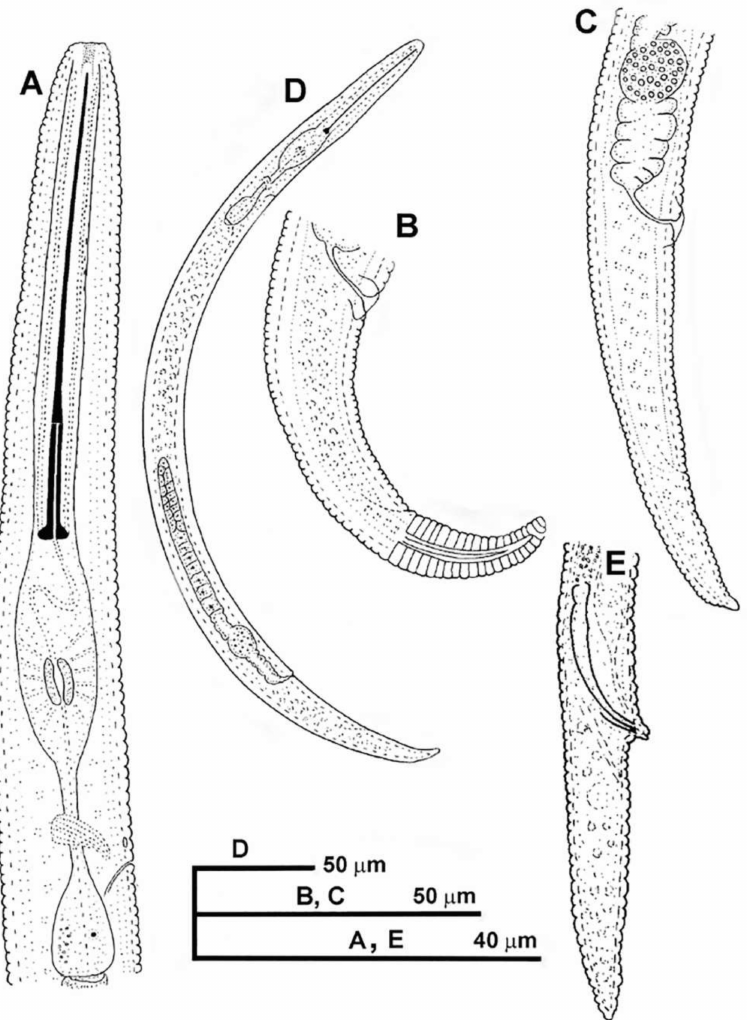
Figure 1. Line drawings of Paratylenchus parastraeleni sp. nov. ( A ): Female pharyngeal region; ( B , C ): Female posterior region; ( D ): Entire female; ( E ): Male posterior